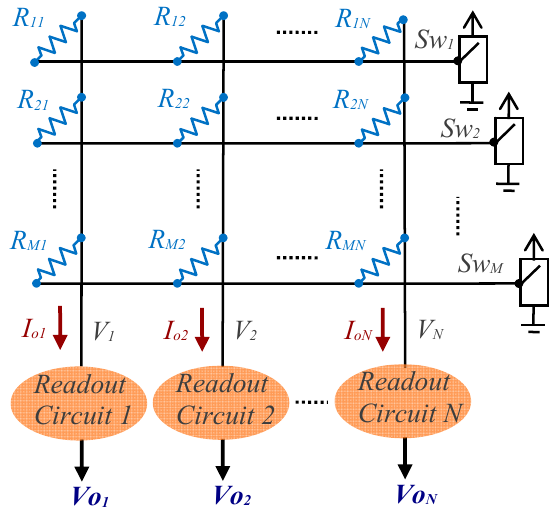
Figure 1. Basic structure of electronics for reading a resistive sensor array.